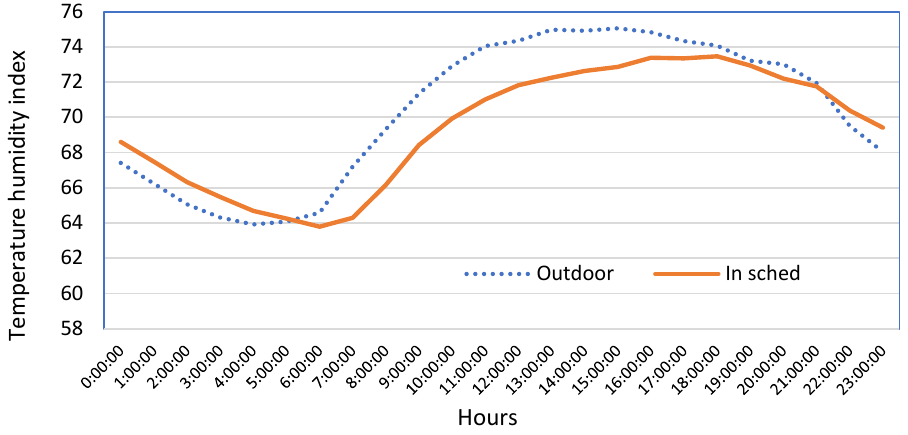
Figure 7. Average daily air temperature and humidity index change in the first decade of July (7 cowshed) .